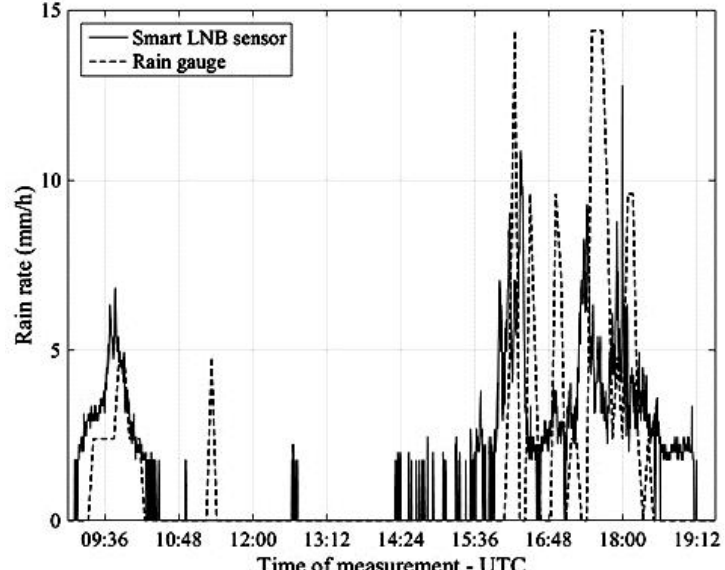
Figure 11. Pisa, 6 May 2017. Rain rate estimates provided by the NEFOCAST SmartLNB-based sensor (solid line) and by the TBR (dashed line).